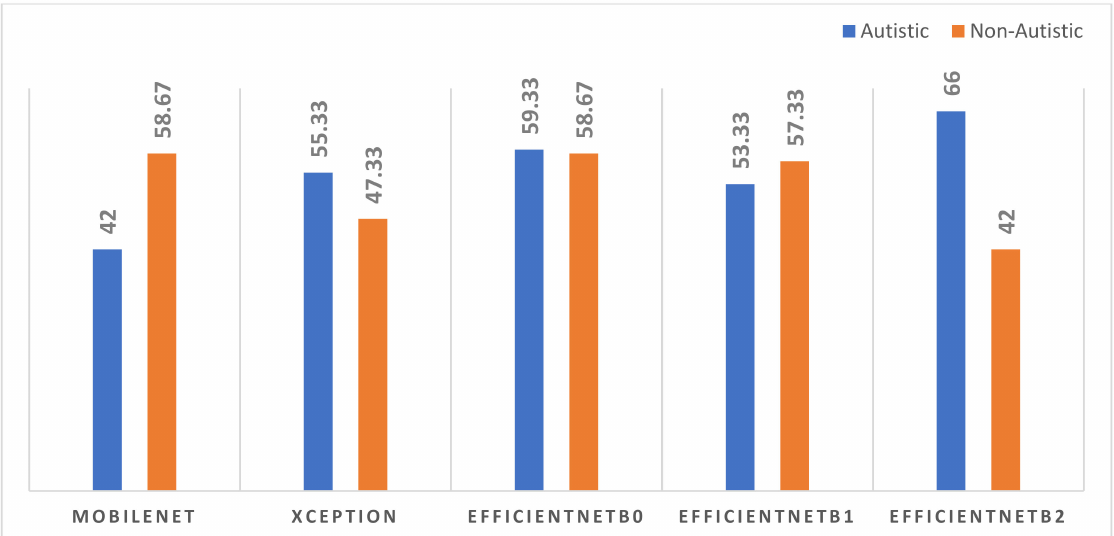
Figure 13. Comparison of the models’ performance based on prediction with a 95%